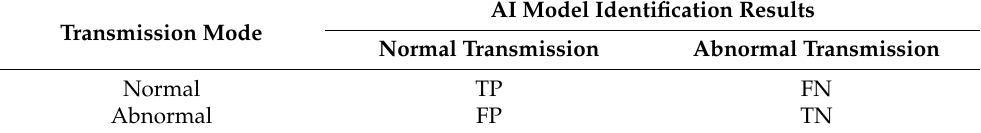
Table 5. Definition of TP, FP, FN, and TN.